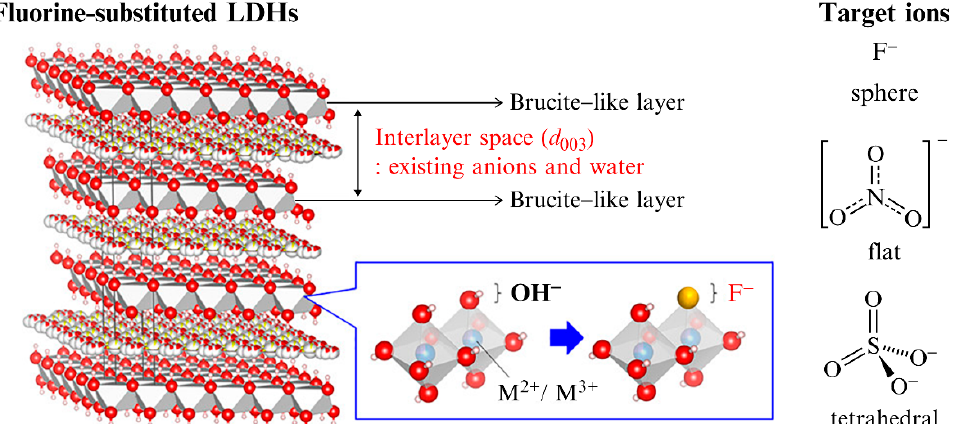
Figure 4. Crystal structure and schematic image of the fluorine substitution of a brucite-like layer of LDHs, visualized using the Visualization for Electronic Structural Analysis program, and molecular structures of the target ion in this study. Reproduced with permission from [33]. Copyright {2020} American Chemical Society.